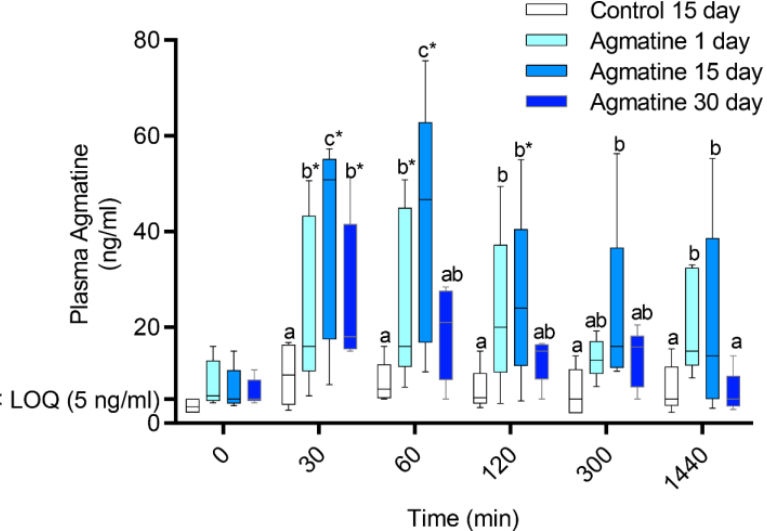
Figure 7. Equine plasma agmatine levels after 1 (light blue), 15 (blue), or 30 (dark blue) days of agmatine, or 15 days of control (white) oral administration. Distinct lowercase letters indicate dif- ferences among treatment/time cohorts (agmatine 1st, 15th, 30th day; control 15th day) within each